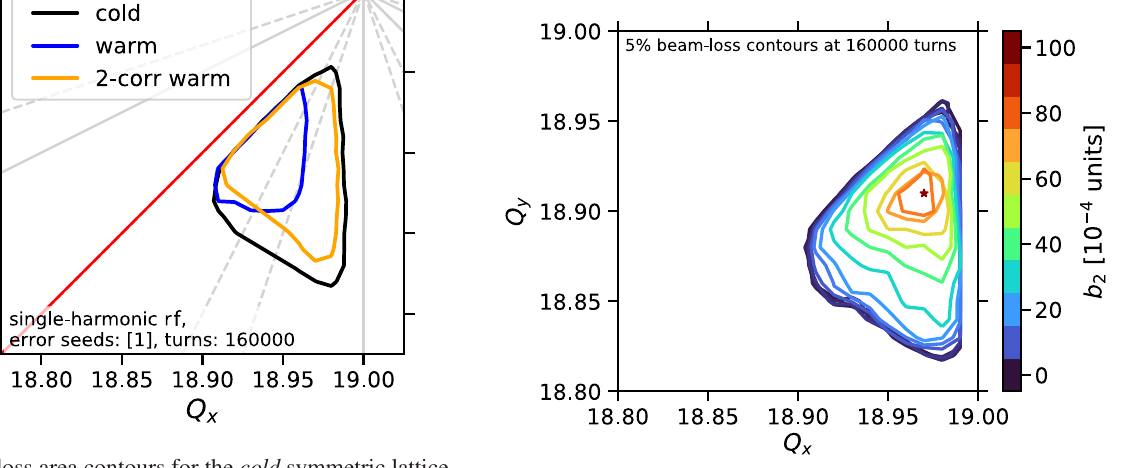
FIG. 14. Tune area contours for a 5% beam-loss threshold during the injection plateau, plotted for various values of the gradient error b 2 . The dark red star marks the asymptotic working point around Q x ¼ 18 . 97 , Q y ¼ 18 . 91